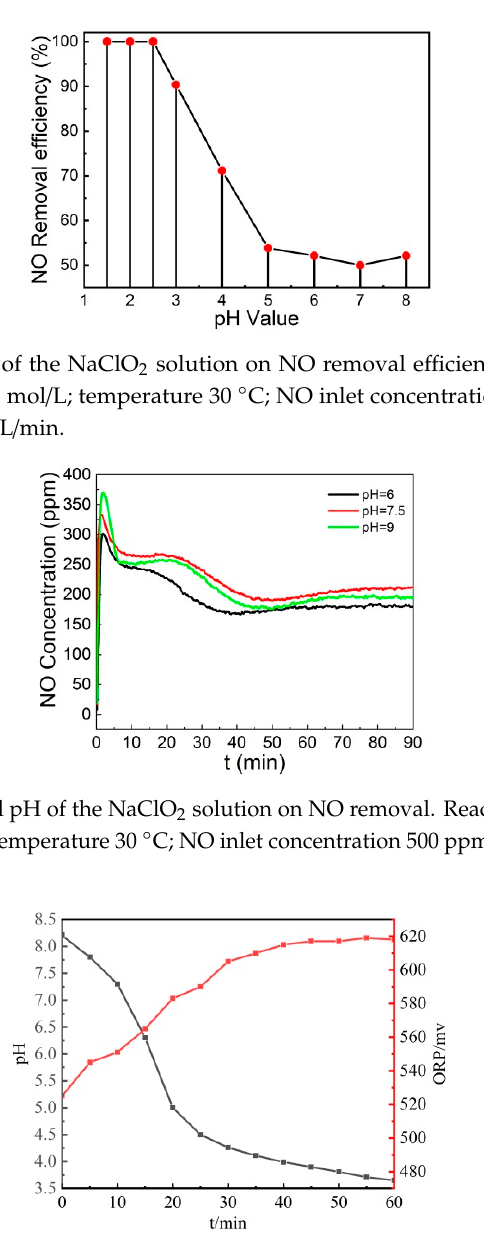
Figure 7. Time courses of pH and ORP value during the reduction by NaClO 2 . Reaction conditions: NaClO 2 concentration 0.008 mol/L; initial pH 8.7; temperature 30 °C; NO inlet concentration 500 ppm; N 2 balance, with a total flow rate of 1.5 L/min.